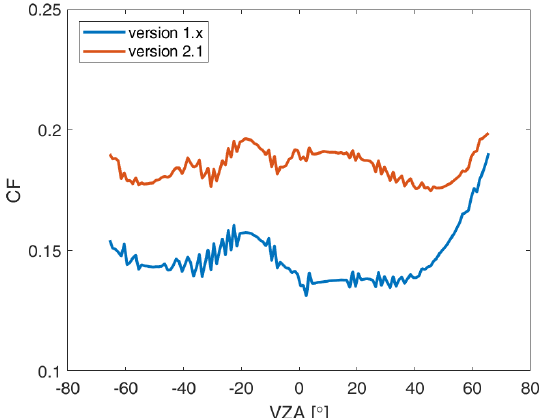
Figure 13. OCRA cloud fractions from the version 1.x and 2.1 pro- cessors in February 2019. Only measurements with 0 < cloud frac- tion < = 0 . 4 are included. The VZA is defined negative for obser- vations on the west side of the orbit